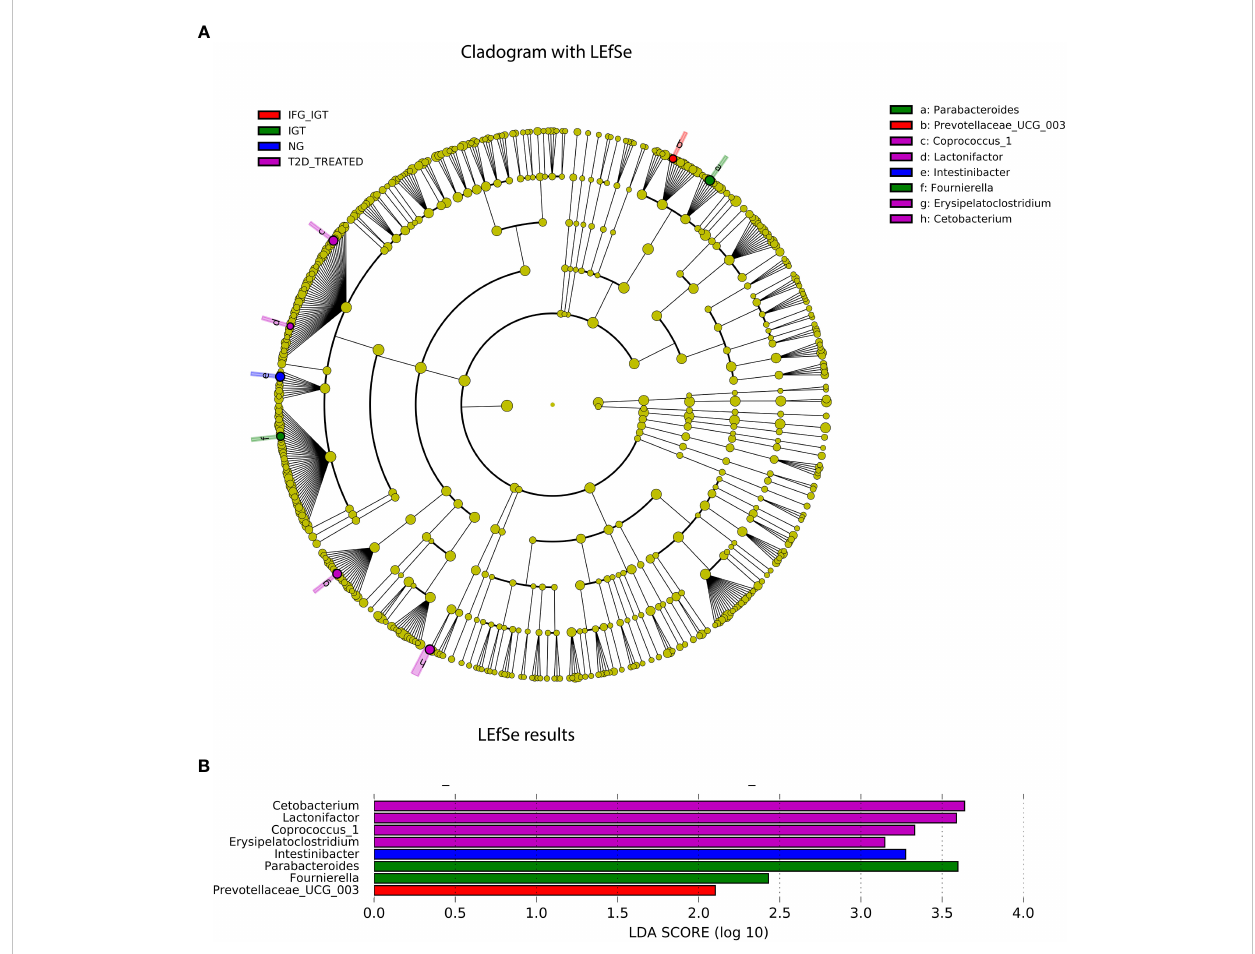
FIGURE 6 LEfSe analysis results. (A) Taxonomic cladogram. Differences are represented by the color of the most abundant genera at each group (NG, IFG, IGT, IFG+IGT, T2D and T2D treated). The diameter of each circle is proportional to the taxon's abundance. (B) The linear discriminant analysis (LDA) value histogram of the GM at genus level and cohort groups (NG, IFG, IGT, IFG+IGT, T2D and T2D